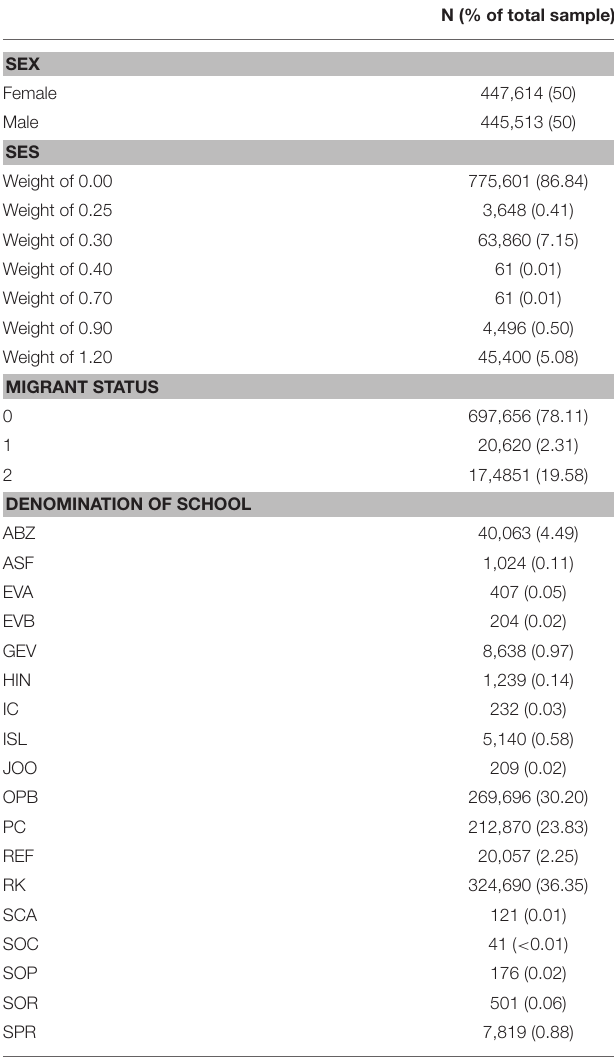
TABLE 1 | Overview of all categorical environmental